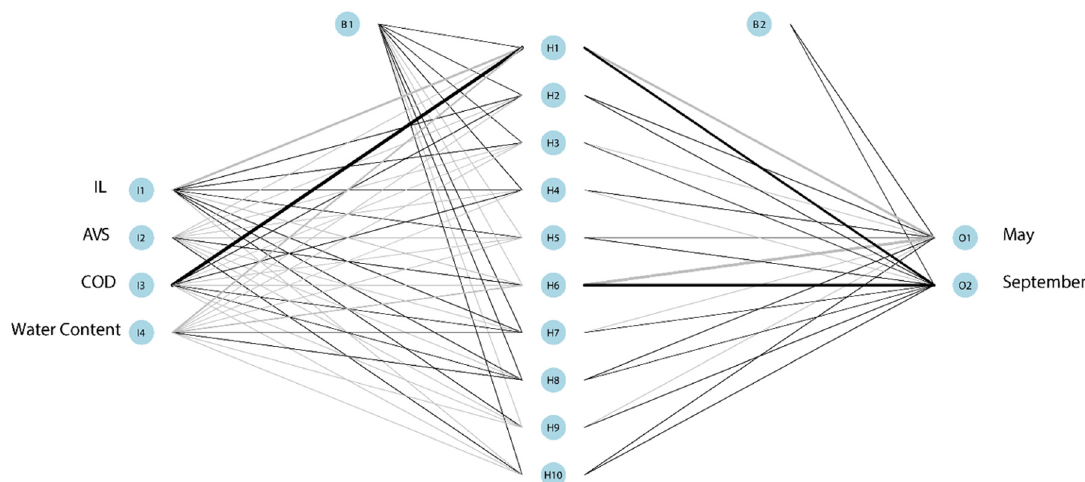
Figure 9. Artificial neural network (ANN) for predicting dinoflagellate cyst abundance in May and September as a function of sediment environmental variables. The thickness of the lines joining the neurons is proportional to the strength of the connection weight. Black lines denote positive connections, and gray lines denote negative connections. One hidden layer was applied. Circles with B indicate additional inputs with layers, and bias are not affected by the previous layer.